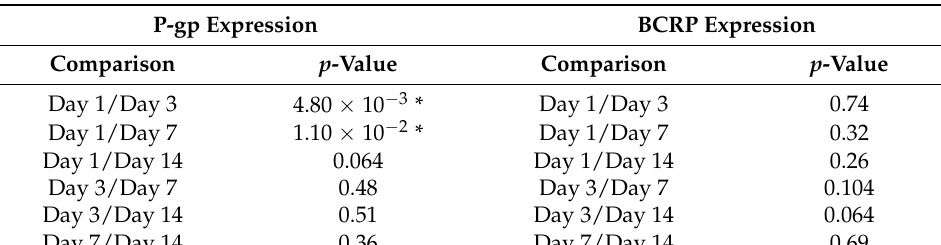
Table 3. p -values from P-gp and BCRP expression comparisons in 18 contralateral ROIs at all time points. p -values were corrected for multiple comparisons (fdr, alpha = 0.05). Corrected p-values less than 0.05 are flagged with one star (*).